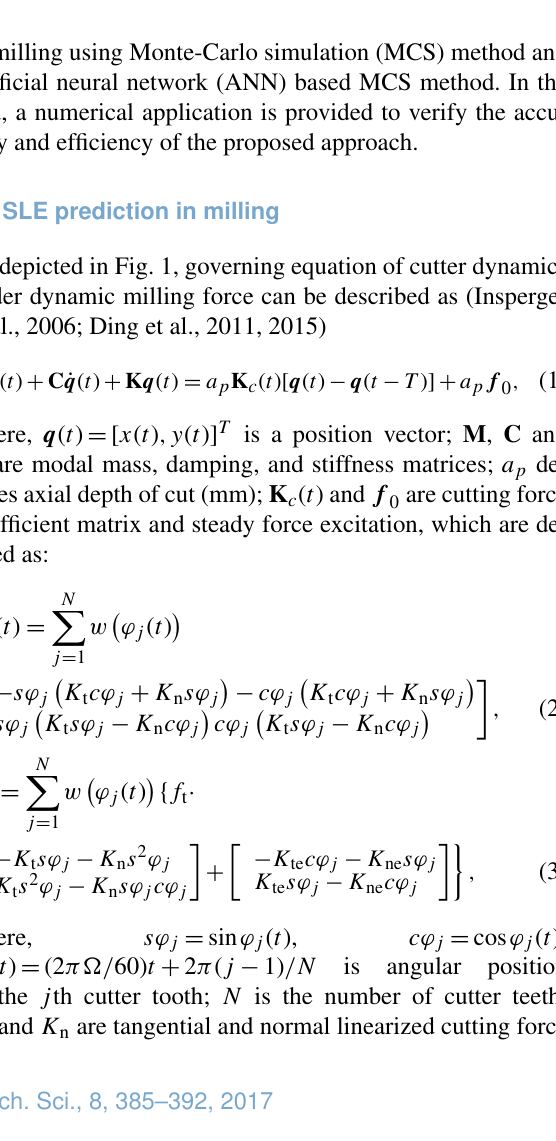
Figure 1. Dynamic model for the milling process. F t –angular position of the j th cutter tooth (rad); (cid:127) – spindle speed (rmin − 1 ); a e – radial depth of cut